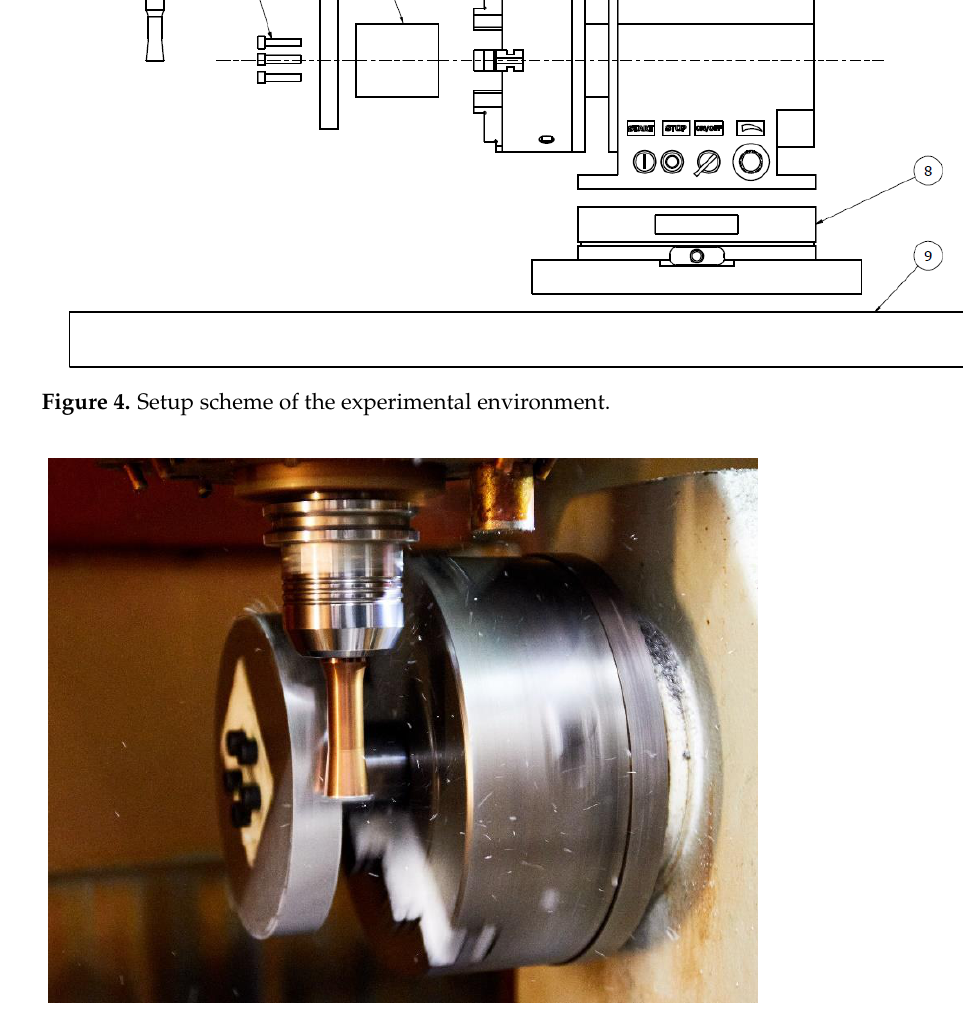
Figure 5. Machining process of Ti-6Al-4V with the rotary tool.